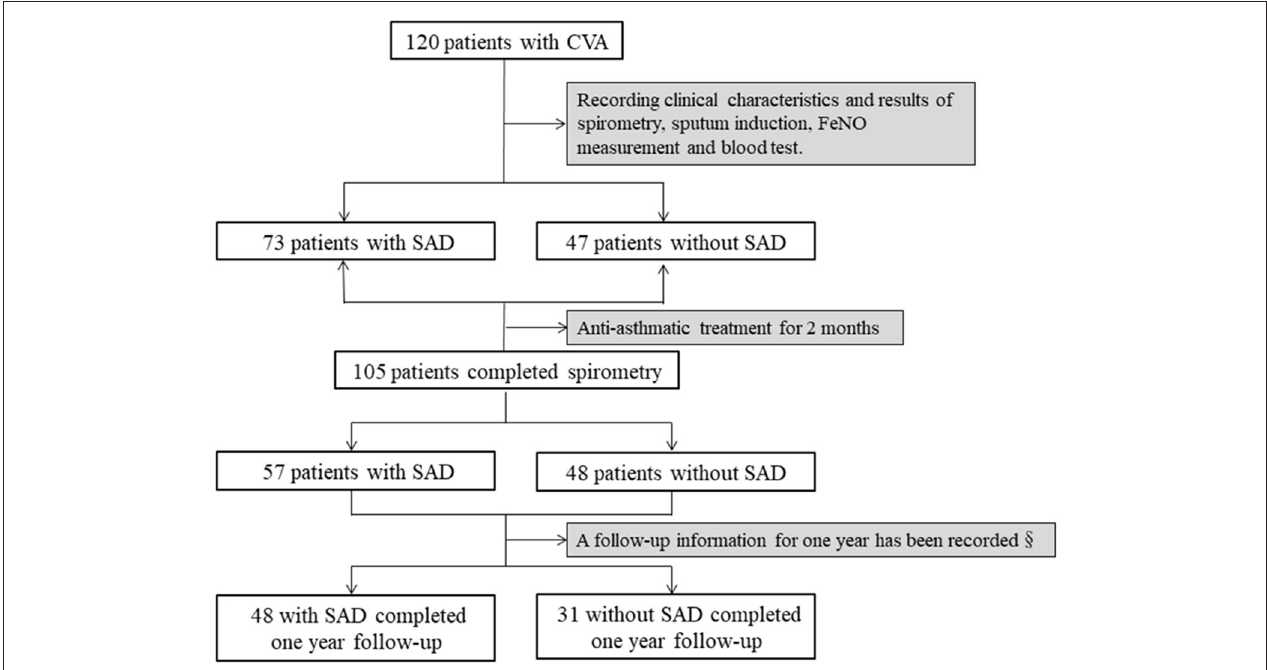
FIGURE 1 | Study profile SAD was identified when any two parameters of MMEF% pred, FEF50% pred, and FEF75% pred were < 65%. Antiasthmatic treatment included budesonide/formoterol (160/4.5 µ g) alone, montelukast alone, or the combination of budesonide/formoterol and montelukast. SAD, small airway dysfunction; §, asthma medication of the patients was withdrawn after 2 months of treatment; MMEF, maximal mid-expiratory flow; FEF50%, forced expiratory flow at 50% of forced vital capacity; FEF75%, forced expiratory flow at 75% of forced vital